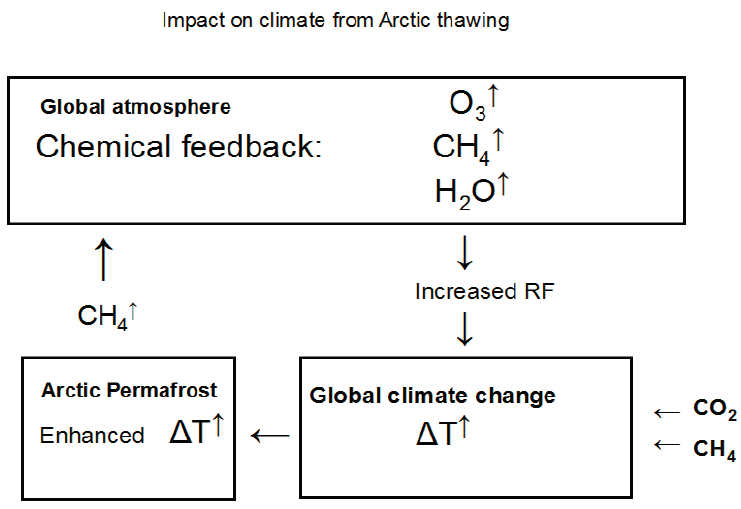
Figure 3. Schematic presentation of climate-chemistry interaction as a result of permafrost thawing and methane emissions.